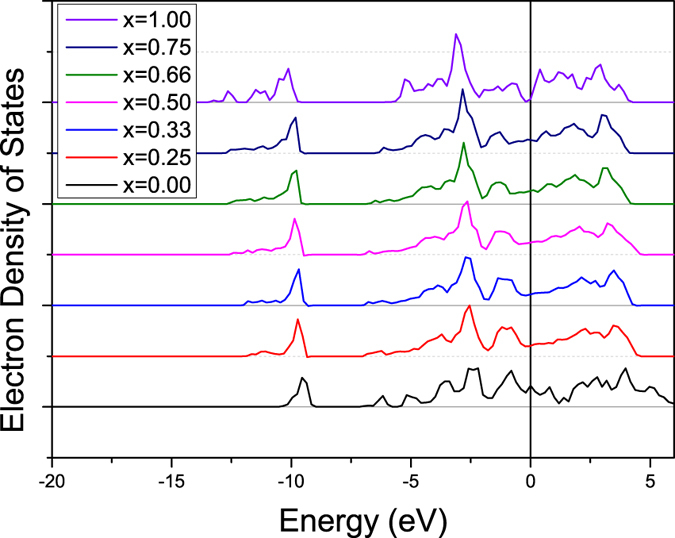
Density of states of Zr2(Al1−xBix)C.The 0 eV value corresponds to the Fermi level.